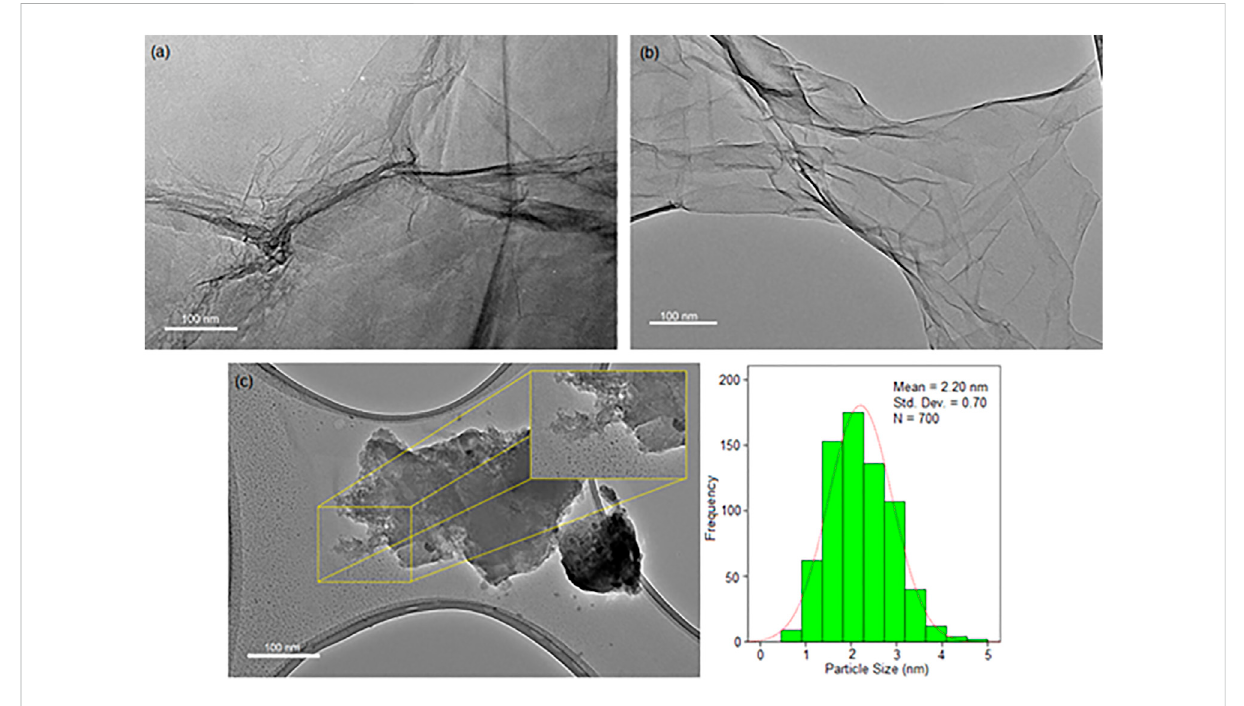
FIGURE 3 HRTEM images of (A) GO, (B) RGO, and (C) H/Cu/RGO